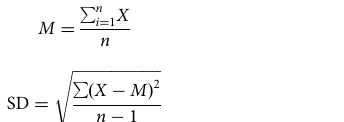
ffiffiffiffiffiffiffiffiffiffiffiffiffiffiffiffiffiffiffiffiffiffiffi ∑ ð X (cid:3) M Þ